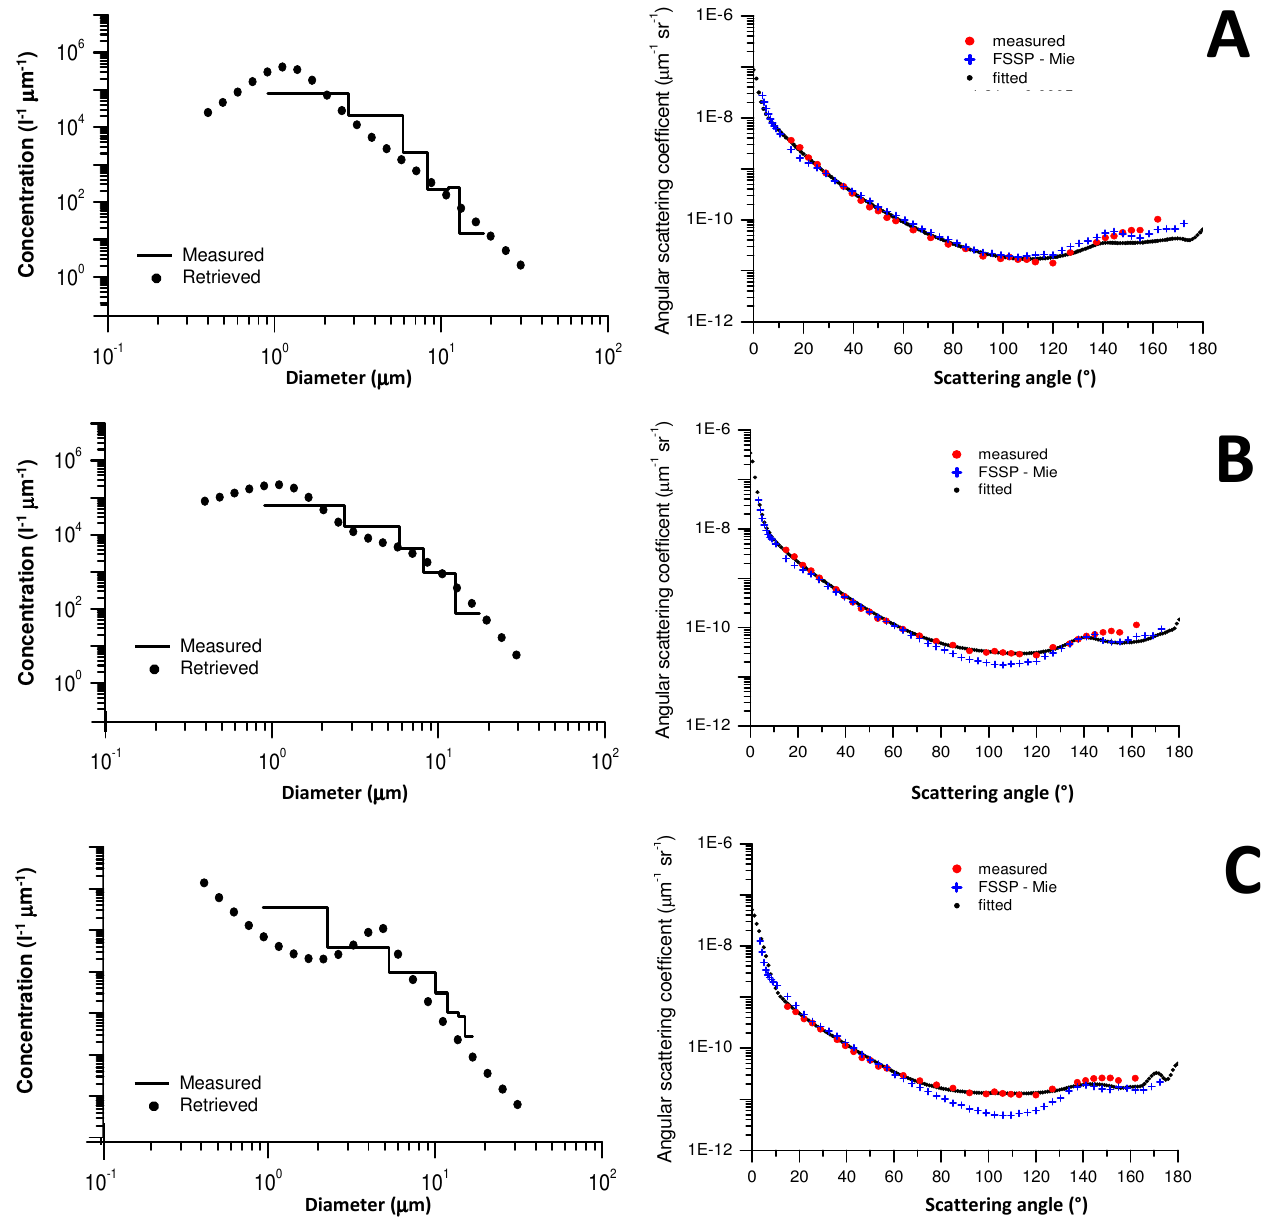
Fig. 4. Left panel: Directly measured particle size distribution (FSSP-300, black lines) and particle size distribution retrieved from the measured scattering phase function (solid black circles). Right panel: Average scattering phase function (solid red circles), theoretical phase function (blue plus-symbols) calculated for spherical ice particles from the FSSP-300 size distribution, and retrieved (solid black circles) scattering phase function. Cases A, B and C refer to the sampling times shown in Fig. 2 at different contrail ages, 50s, 105s and 205s,